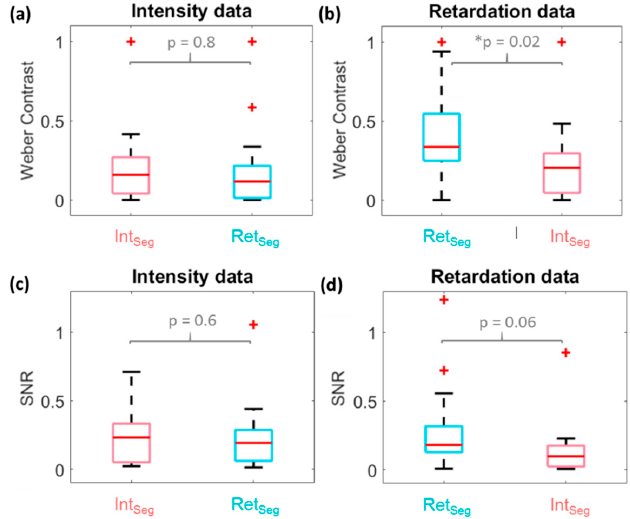
Figure 2. Comparison of plaque segmentation in intensity and retardation data. ( a ) Maximum intensity en-face projection image. ( b ) Median retardation value en-face projection over 50 µm. Color Figure 1. ( c ) Intensity B-scan with segmented plaques shown in red. ( d ) Retardation B-scan with segmented